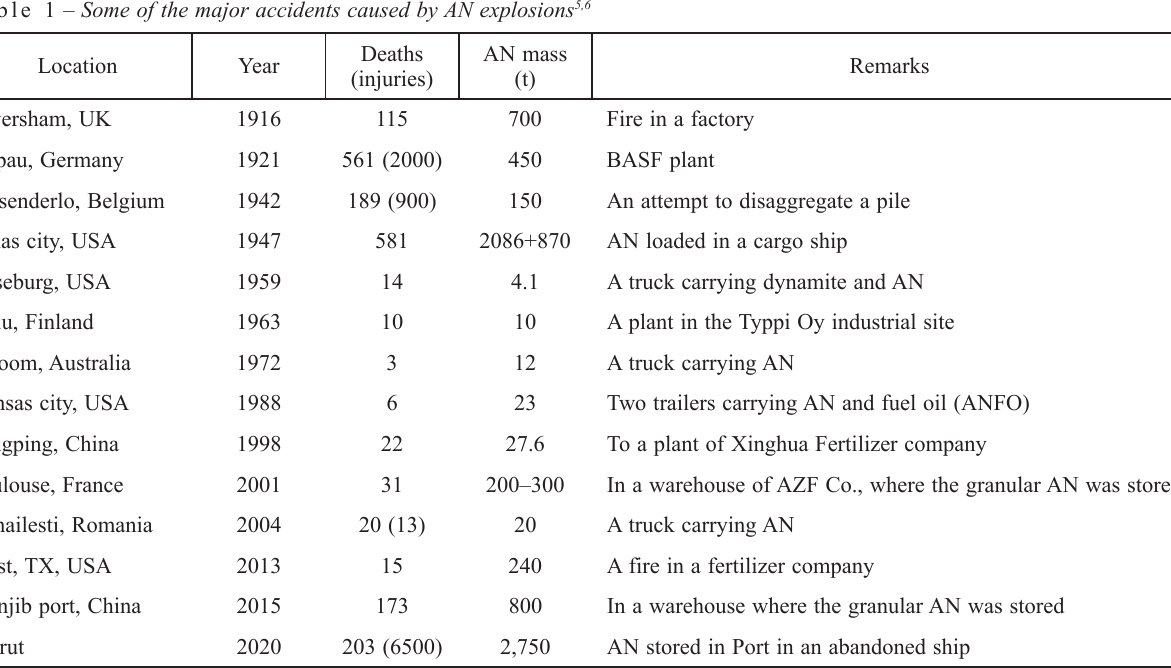
Table 1 – Some of the major accidents caused by AN explosions 5,6